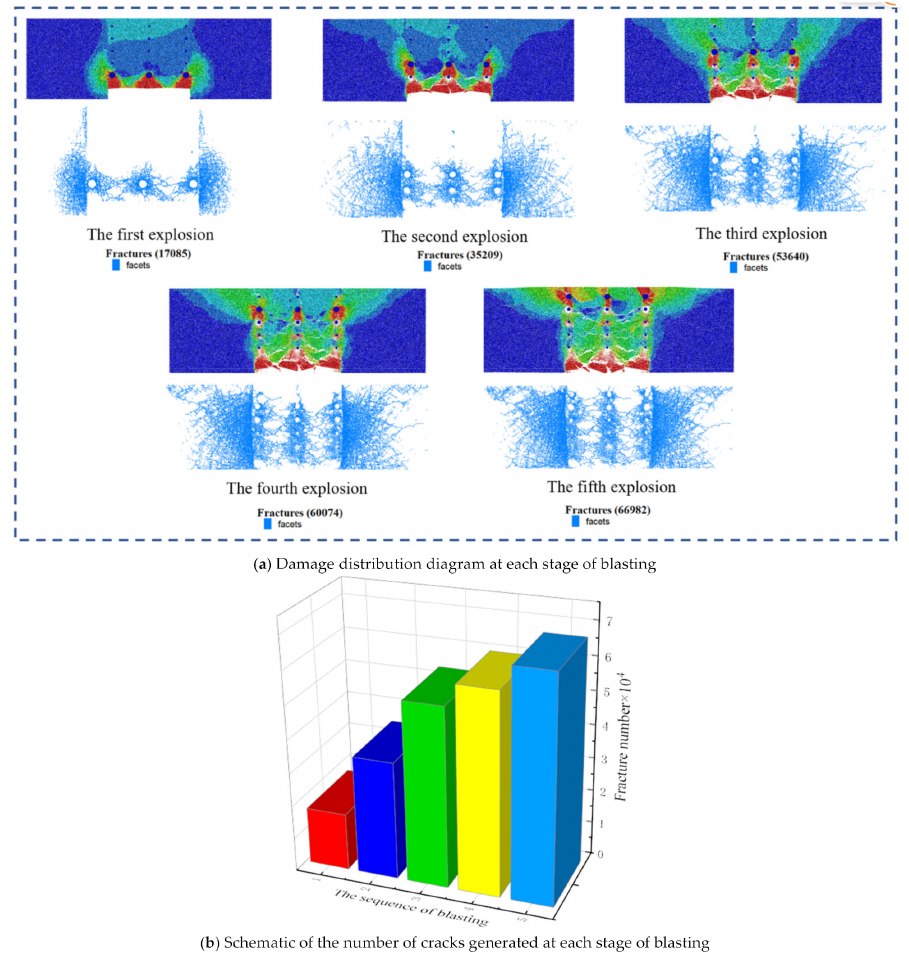
Figure 12. Evolution process of backfill